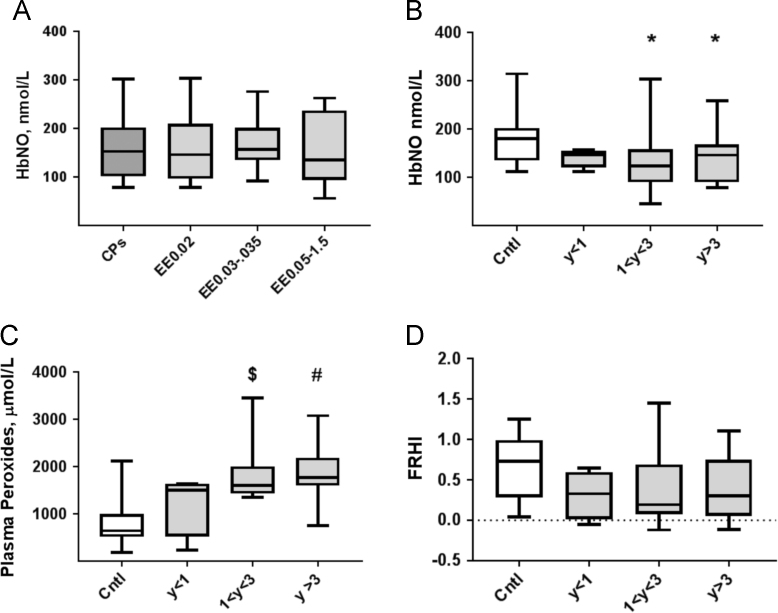
Erythrocyte HbNO, plasma peroxides concentrations and FRHI in users of CP containing different amounts of ethinyl estradiol or after different durations of CP consumption. A. HbNO levels in venous erythrocytes of CP users consuming CPs containing ethinyl estradiol (EE) at different concentrations: 0.02 mg (n=37); 0.03–0.035 mg (n=17) and 0.05–1.5 mg (n=8). B. Erythrocyte HbNO levels; C. plasma levels of biological peroxides; D. indexes of reactive hyperemia response (FRHI) in control subjects and subjects consuming CPs during different periods: T < 1; 1 < T < 3; T > 3 years. * P < 0.05; $ P < 0.001; # P < 0.0001 compared by one-way ANOVA with Dunn׳s correction for multiple comparisons to Cntl.